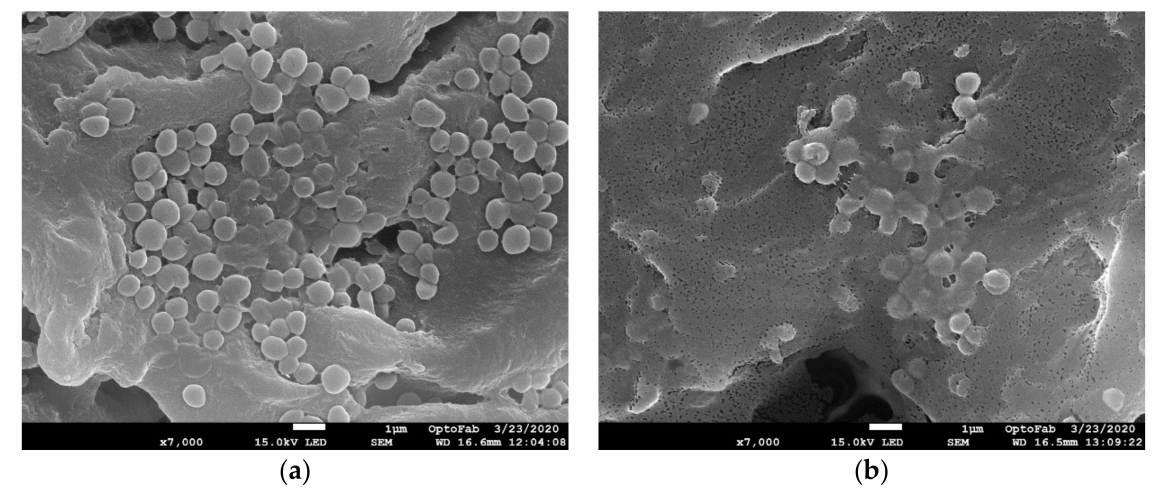
Figure 5. Scanning electronic micrographs of S. aureus biofilm ( a ) Hydrated biofilm ( b ) Dry Surface Biofilm